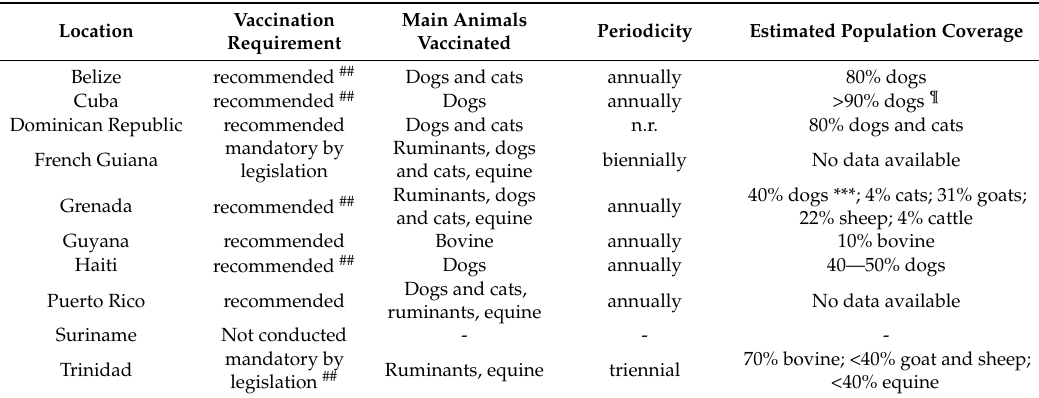
Table 3. National animal rabies vaccination